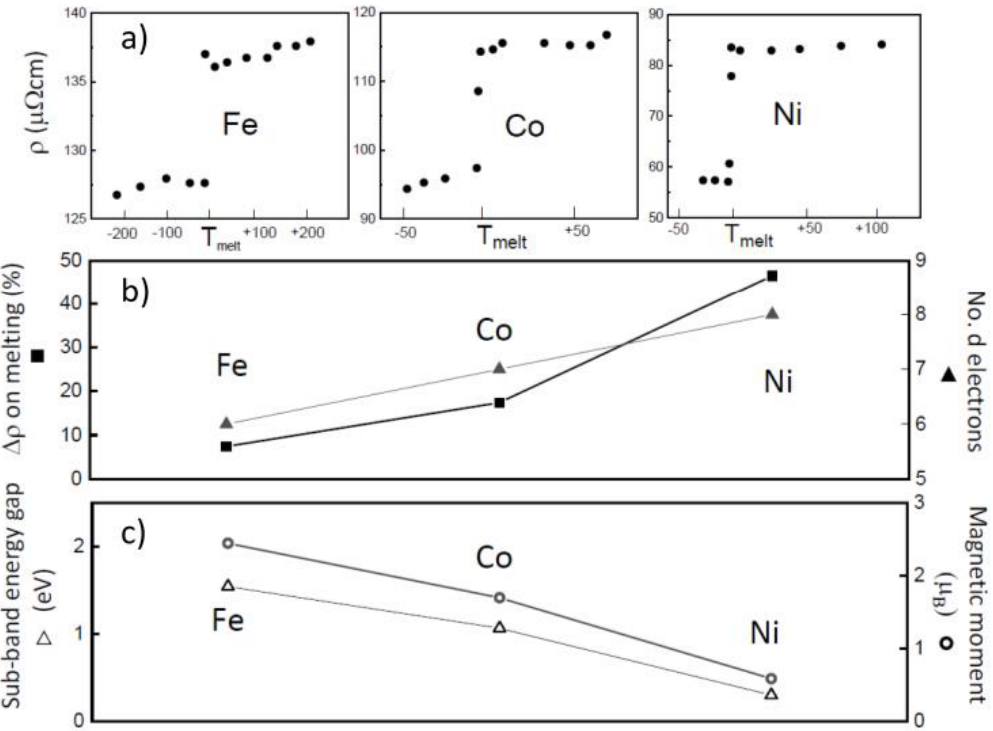
Figure 1. Data of 1 atm of Fe, Co, and Ni. ( a ) Resistivity discontinuity [38] on melting (note the differences in resistivity scale for Fe, Co, and Ni, whose melting T’s are 1809 K, 1768 K, and 1728 K, respectively); ( b ) resistivity discontinuity on melting and number of occupied d- electron band, and; ( c ) sub-band energy gap and magnetic moments [34,50].